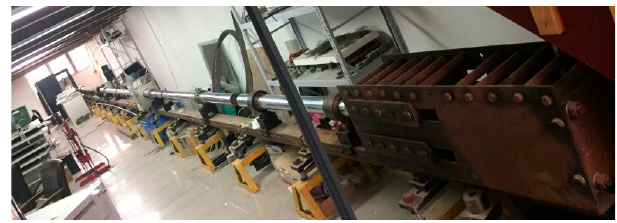
Figure 8. SHPB(Split Hopkinson Pressure Bar) test device diagram.